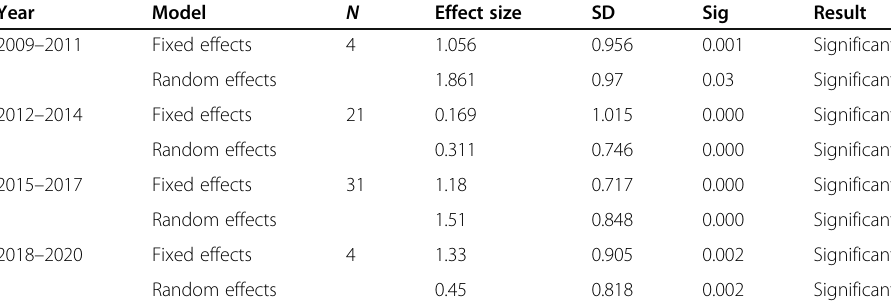
Table 8 Effect size by year of